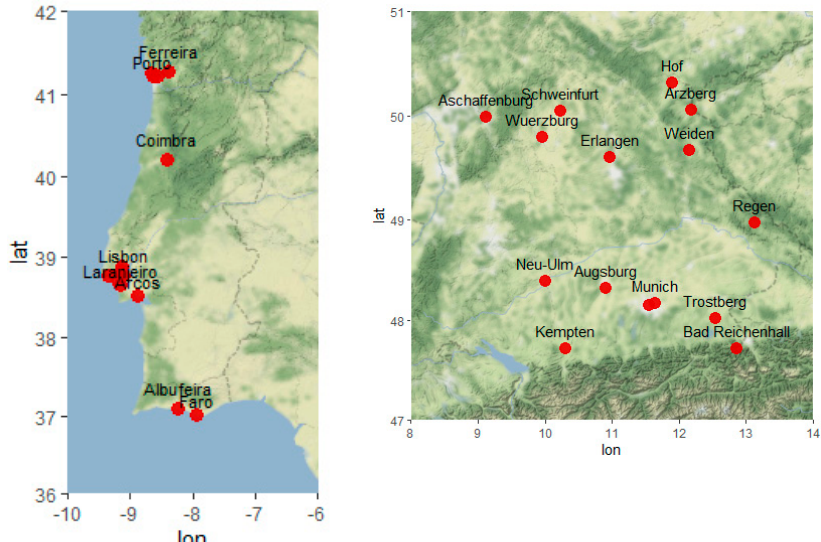
Figure 1. Location of the ozone stations used in this study. Left: Portugal, right: Bavaria, Germany.